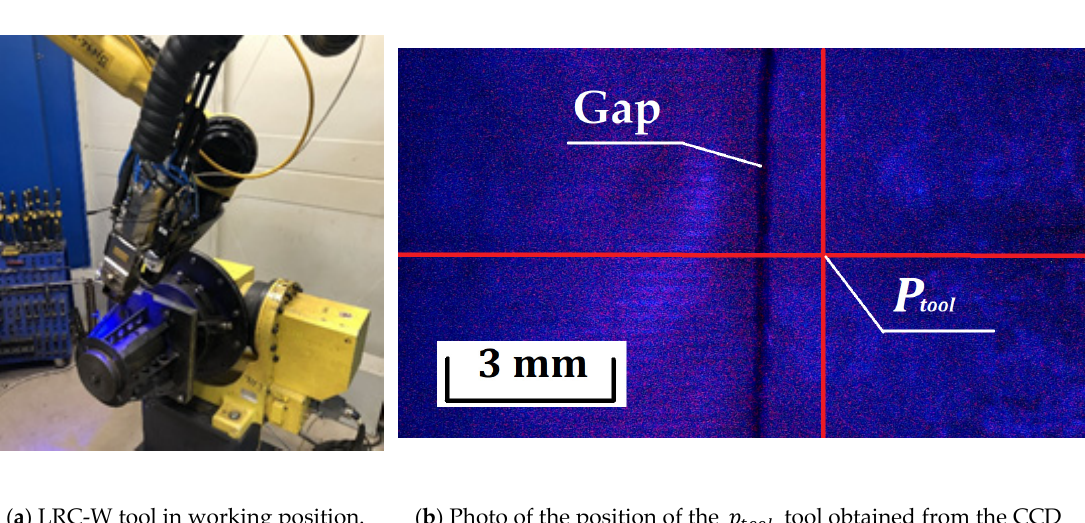
Figure 1. Positioning of the LRC-W tool in the process of planning a laser tack with an inaccurately located point of the trajectory relative to the gap between workpieces.